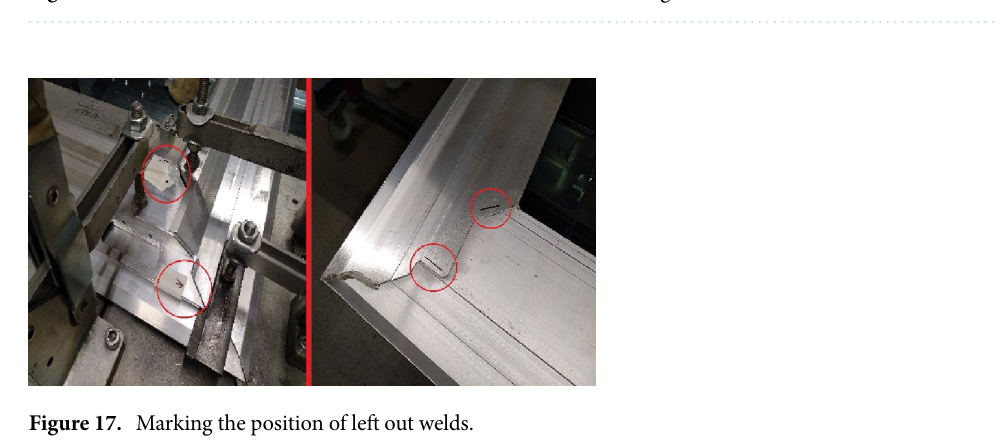
Figure 16. Corner G of the door frame for current variant after welding.